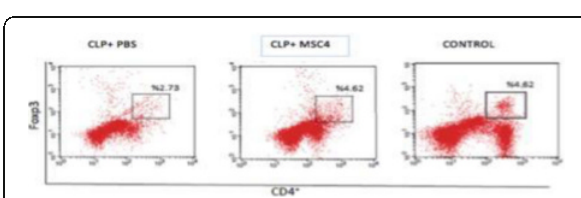
Fig. 58 (abstract A143). Flowcytometric analysis of Treg cells